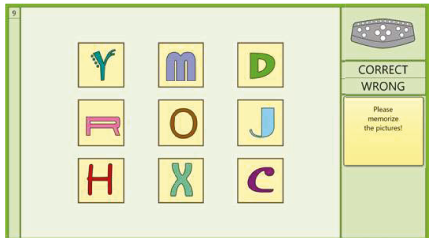
Figure 6: Example training on level 9, of the topological memory task RehaCom